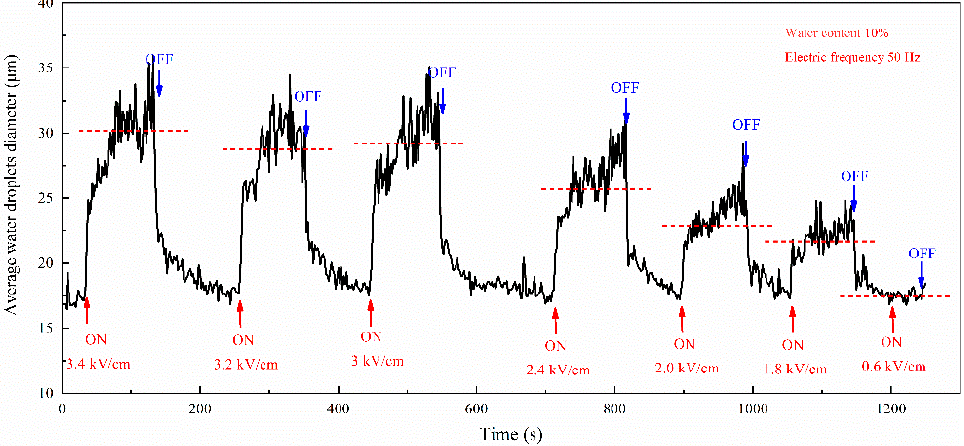
Figure 15. Variations of average water droplet size under different electric field parameters (water content 10%).